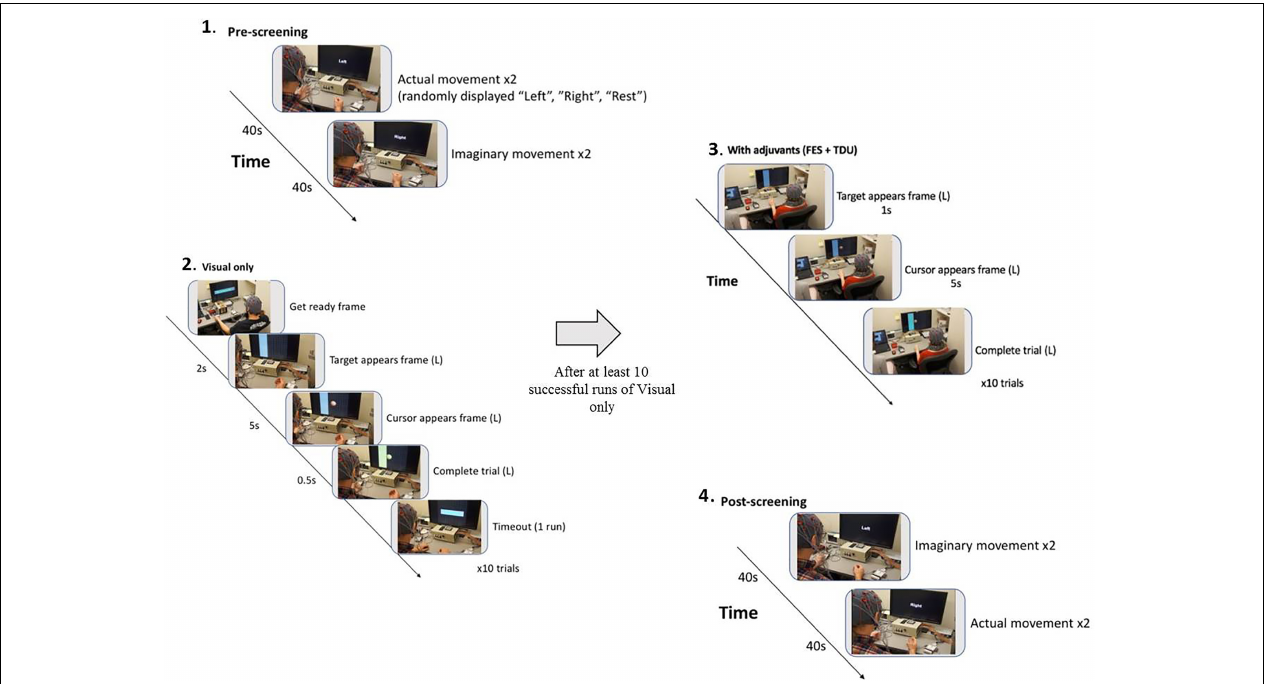
FIGURE 2 | BCI intervention block design. (1) Pre-screening (two actual movement trials, two imagined movement trials). (2) Cursor task ( ≥ 10 trials with visual-only feedback). (3) Cursor task with adjuvant stimuli ( ≥ 10 trials with adjuvant stimuli). (4) Post-screening (two imagined movement trials, two actual movement trials).